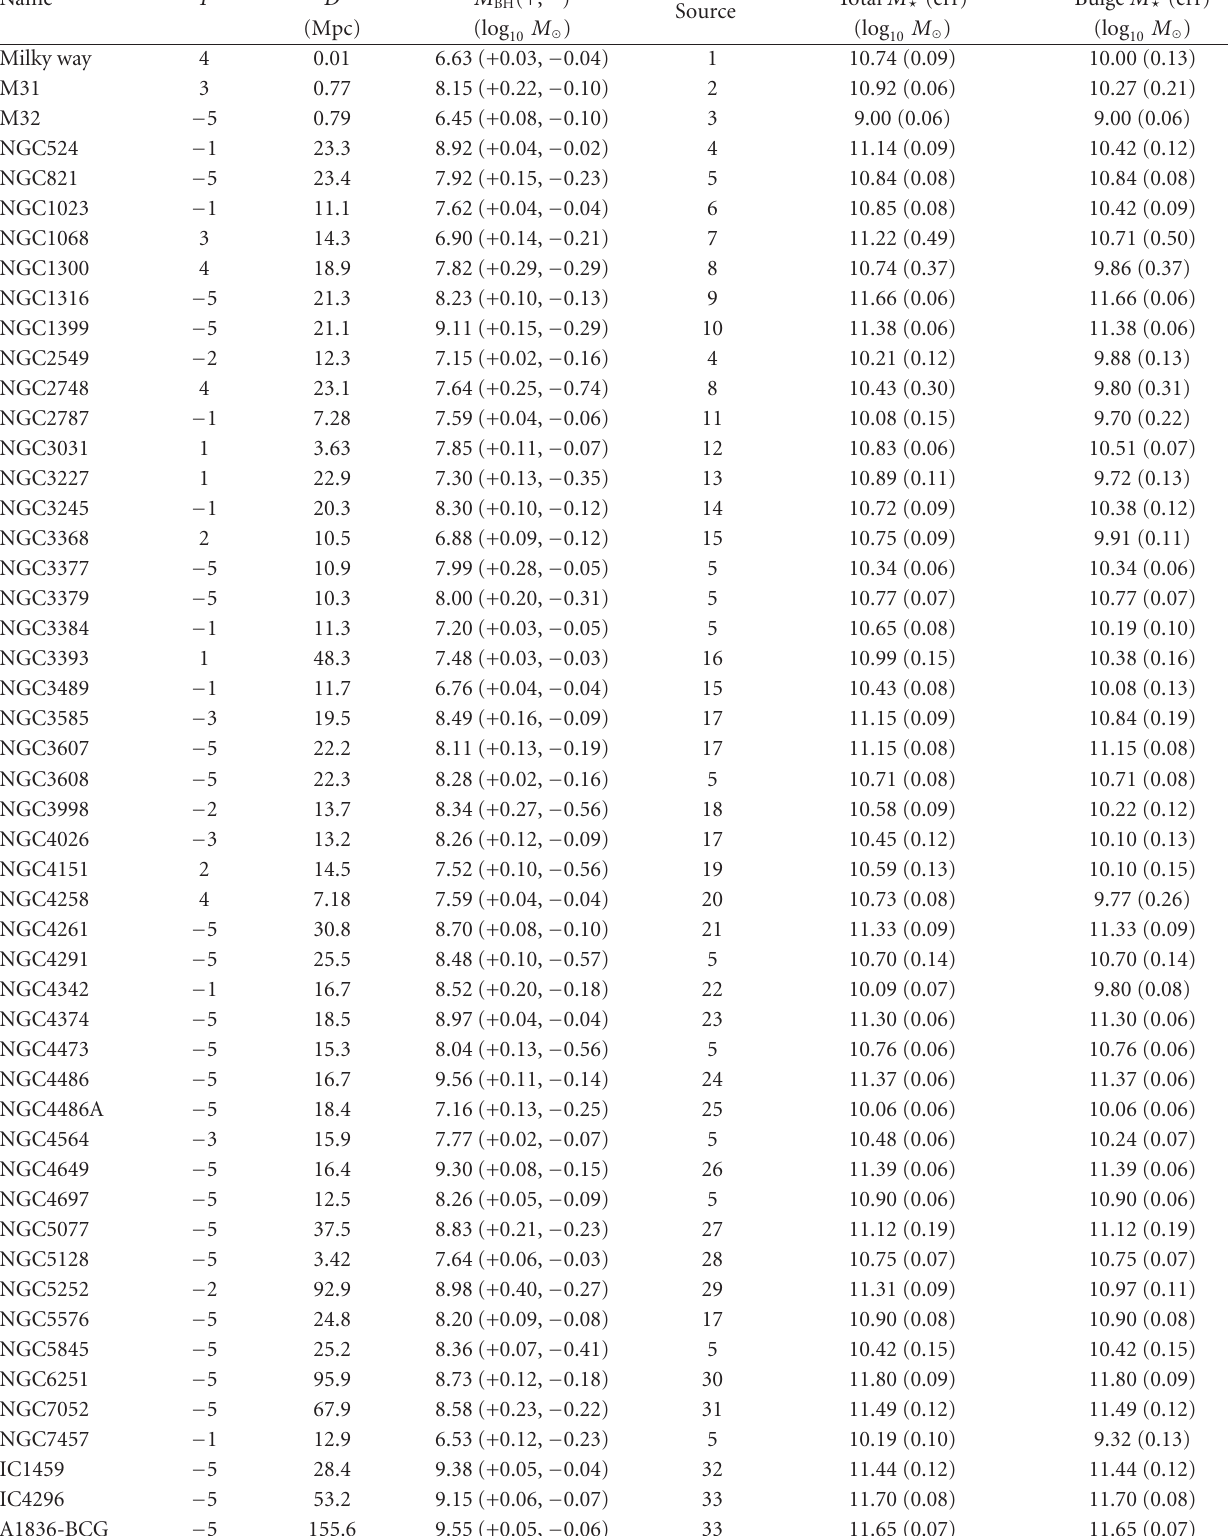
Table 1: Galaxies with well-determined SMBH